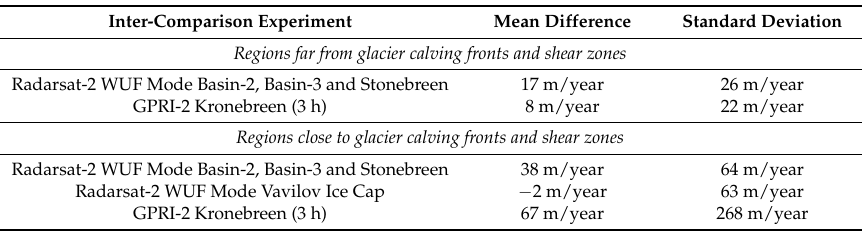
Table 2. Results of the validation of ice surface velocity